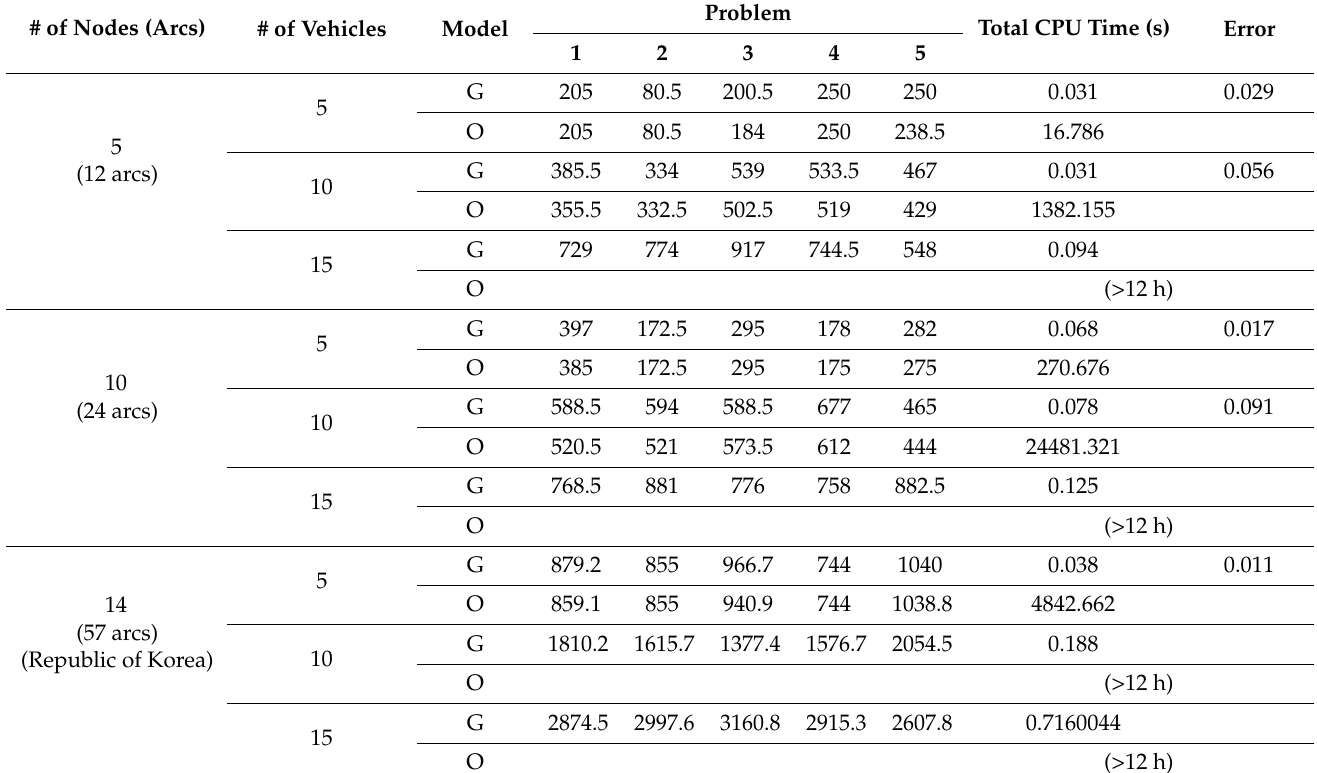
Table 5. Total cost and computation time of numerical